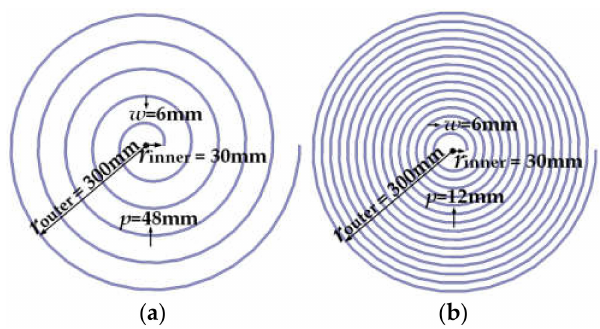
Figure 12. Channel width and coil turns changing: ( a ) 5 turns; ( b ) 15 turns.